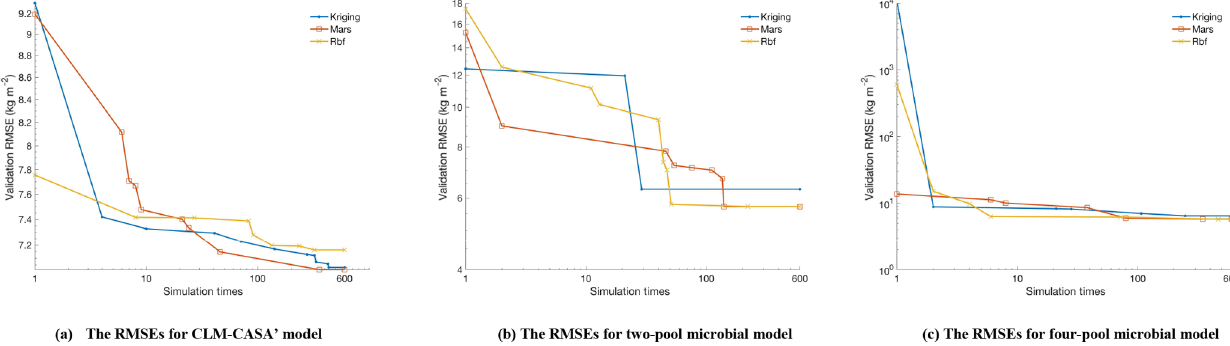
Figure 6. The average RMSEs with the increase of number of simulations and different surrogate